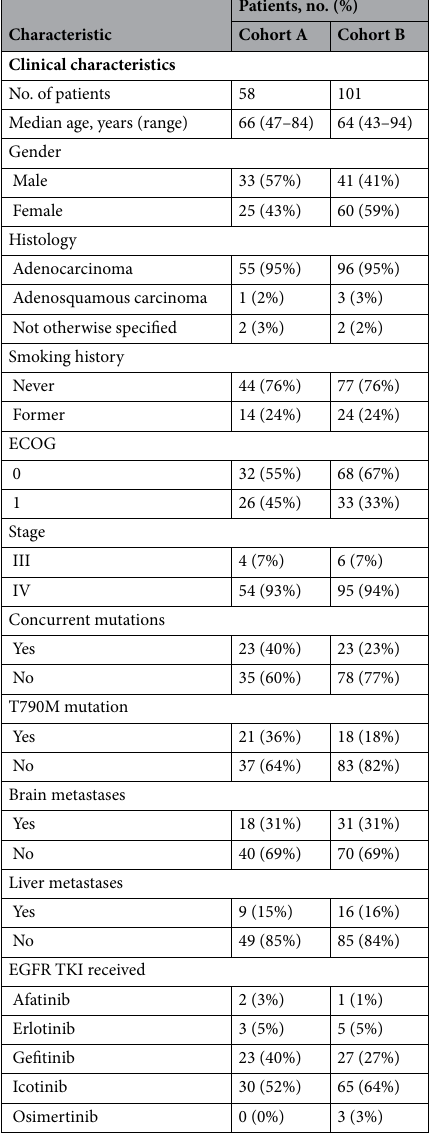
Table 1. Patient characteristics at baseline.